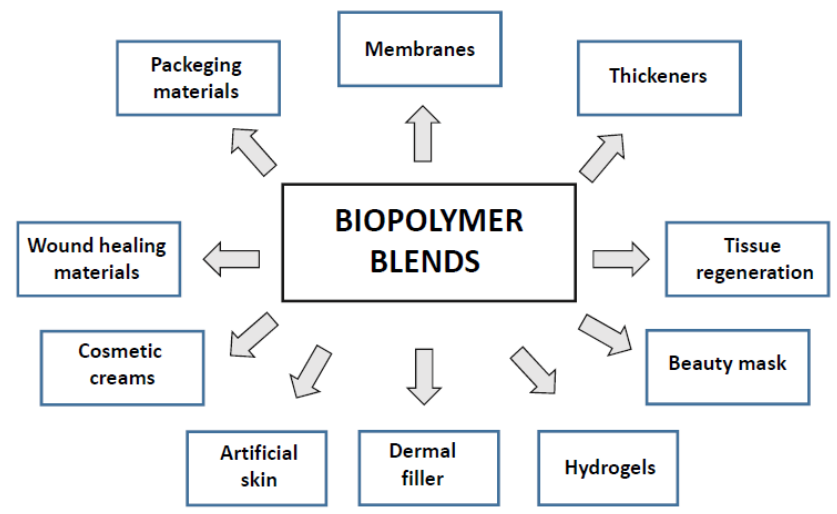
Figure 1. Potential materials based on biopolymer blends.